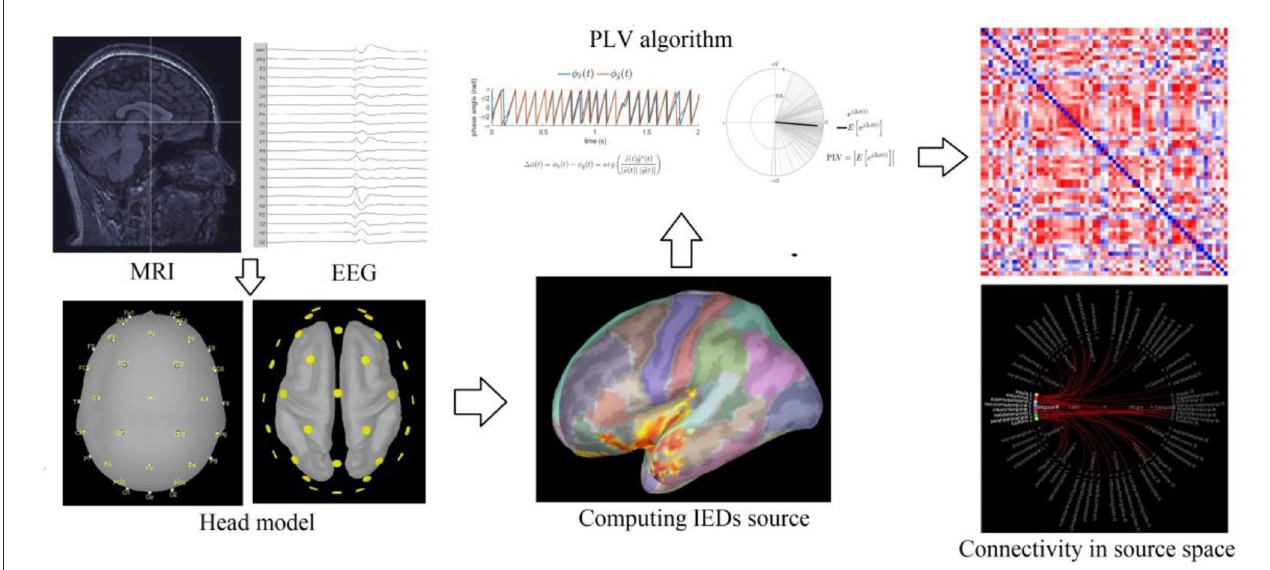
FIGURE1 The processing process of IEDs source